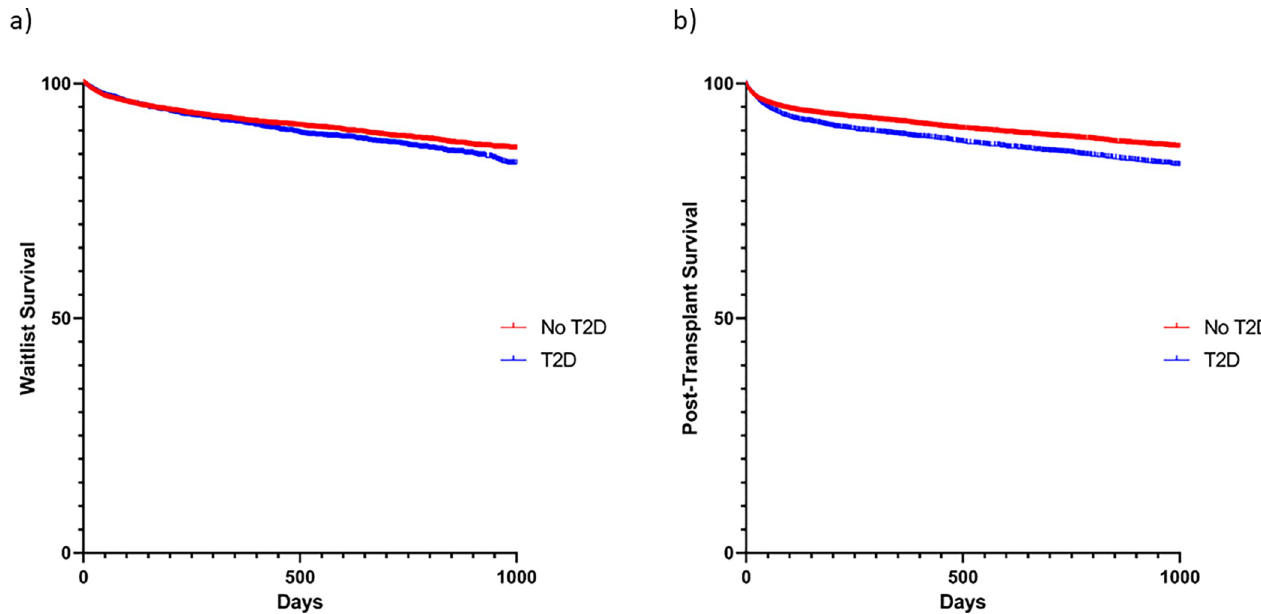
Fig 2. Kaplan meier analysis for waitlist survival, and post-transplantation survival (a) Waitlist Survival (b) Post-Transplant Survival.